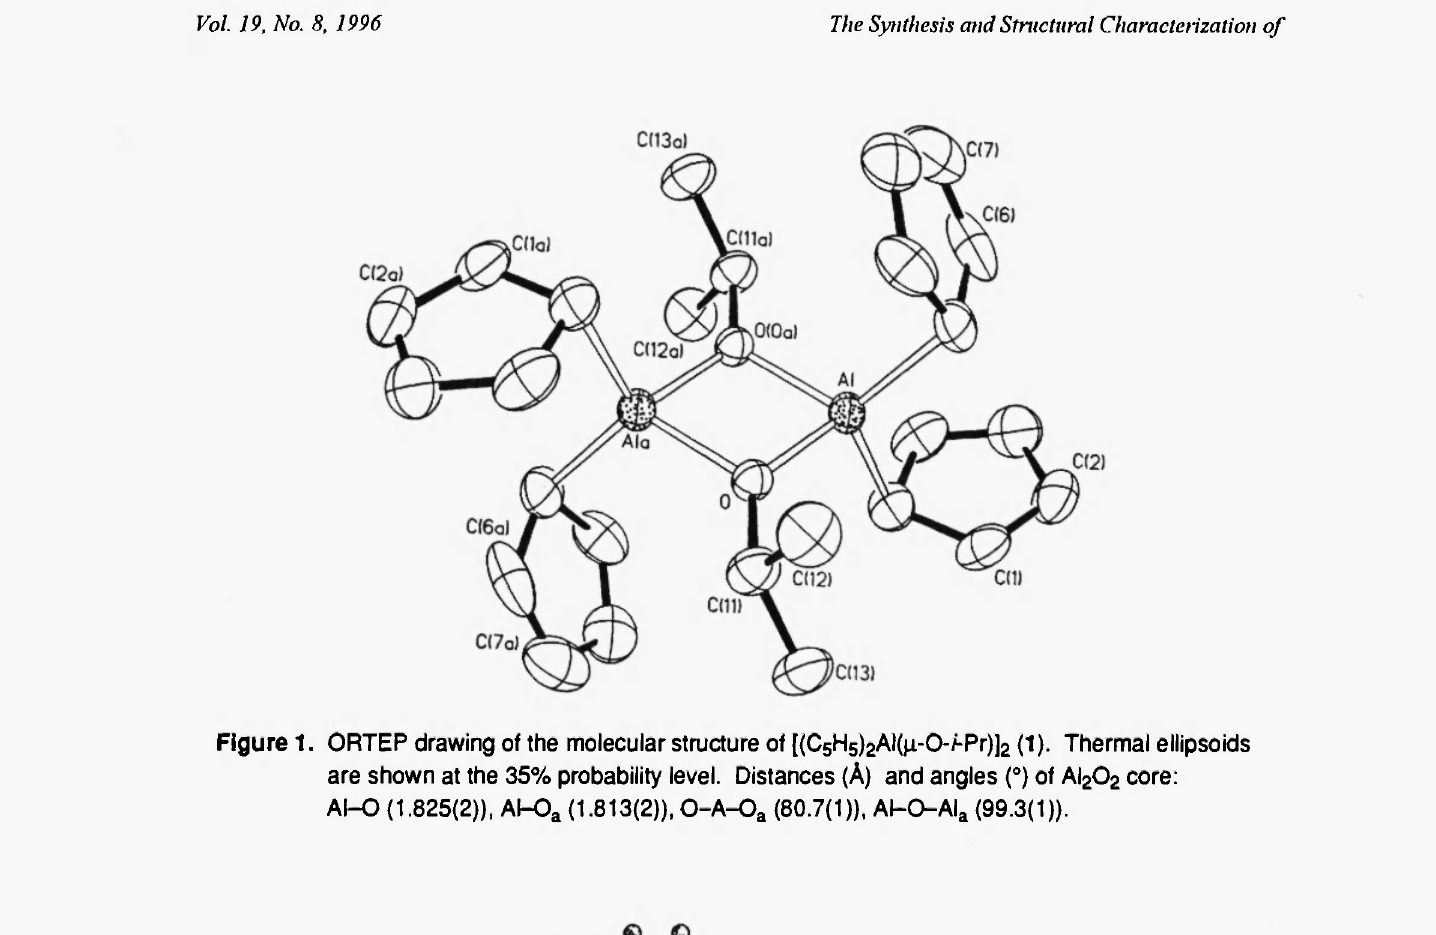
Figure 1. ORTEP drawing of the molecular structure of [(0 5 Η5) 2 ΑΙ(μ-Ο-ΑΡΓ)]2 (1). Thermal ellipsoids are shown at the 35% probability level. Distances (A) and angles (°) of Al 2 0 2